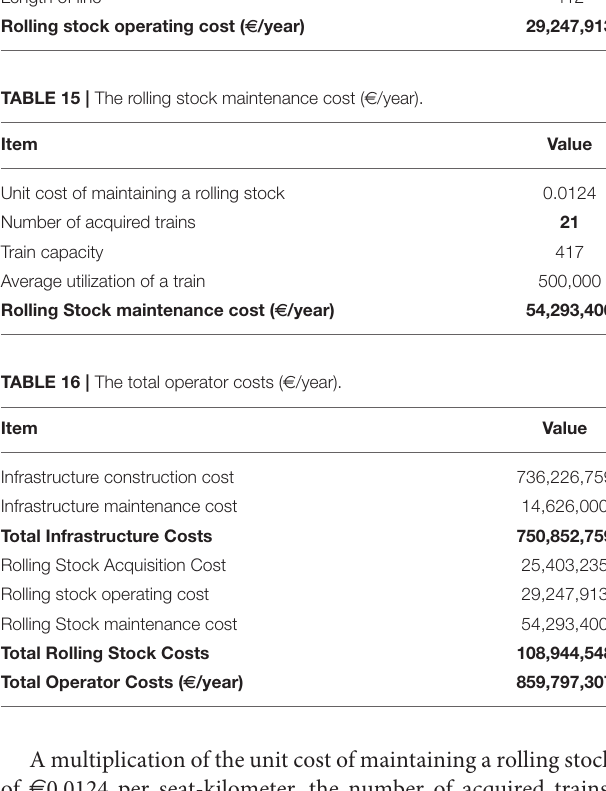
TABLE 13 | The rolling stock acquisition Cost ( e /year).